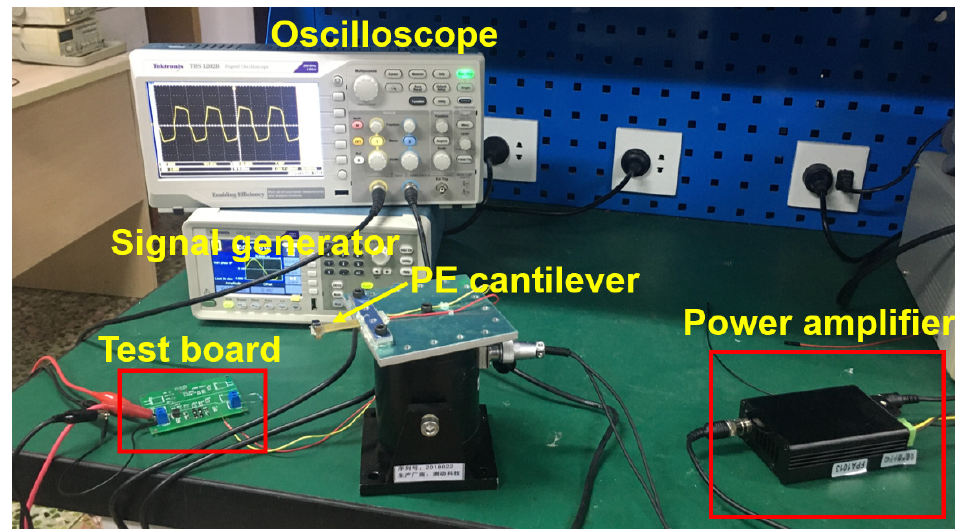
Figure 12 . Experimental setup . Figure 12. Experimental setup.